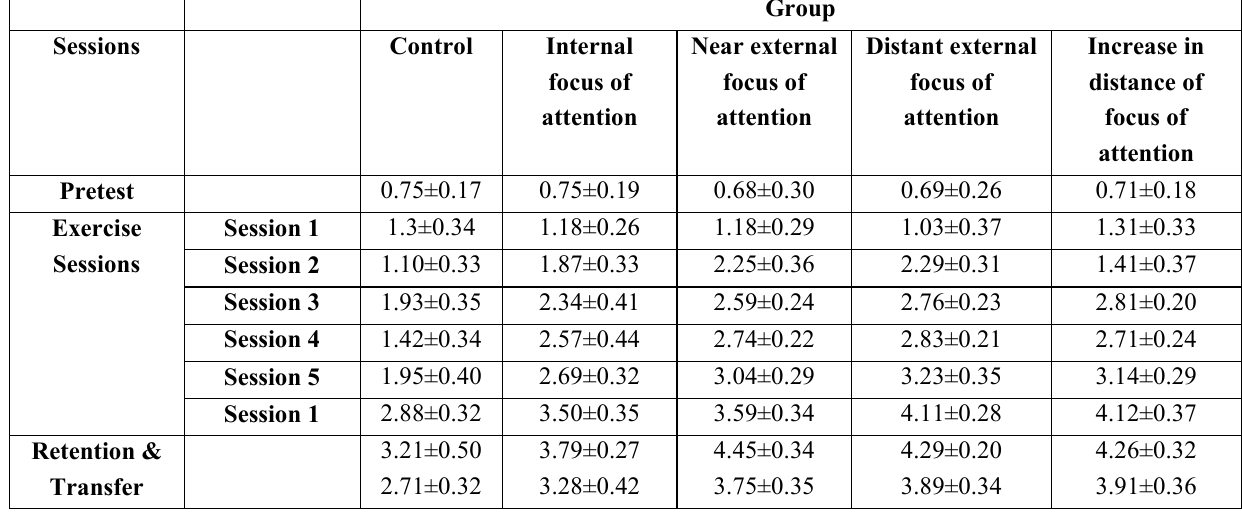
Backhand Accuracy Scores in Six Exercise Sessions